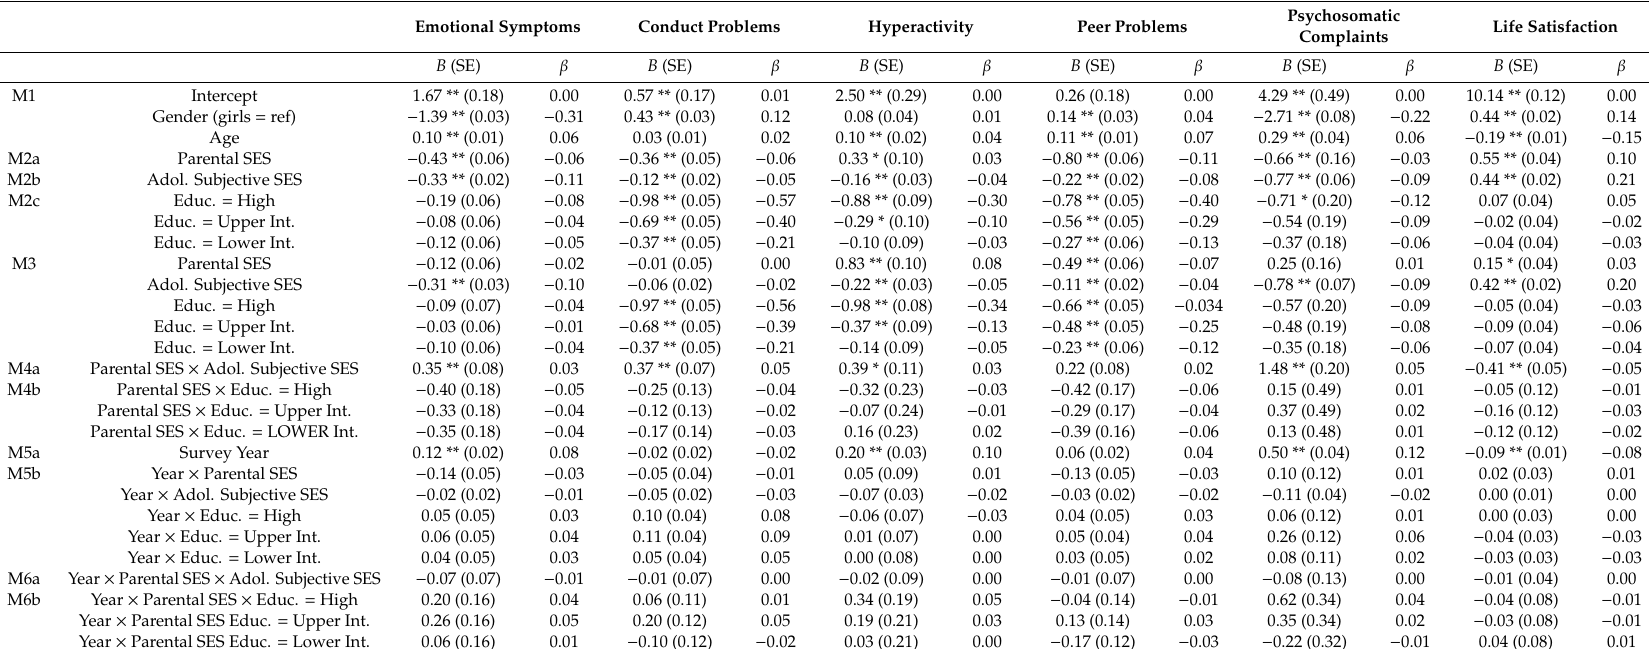
Table 3. Regression models 1–6b showing the e ff ects of SES indicators on six adolescent mental health problems. Emotional Symptoms Conduct